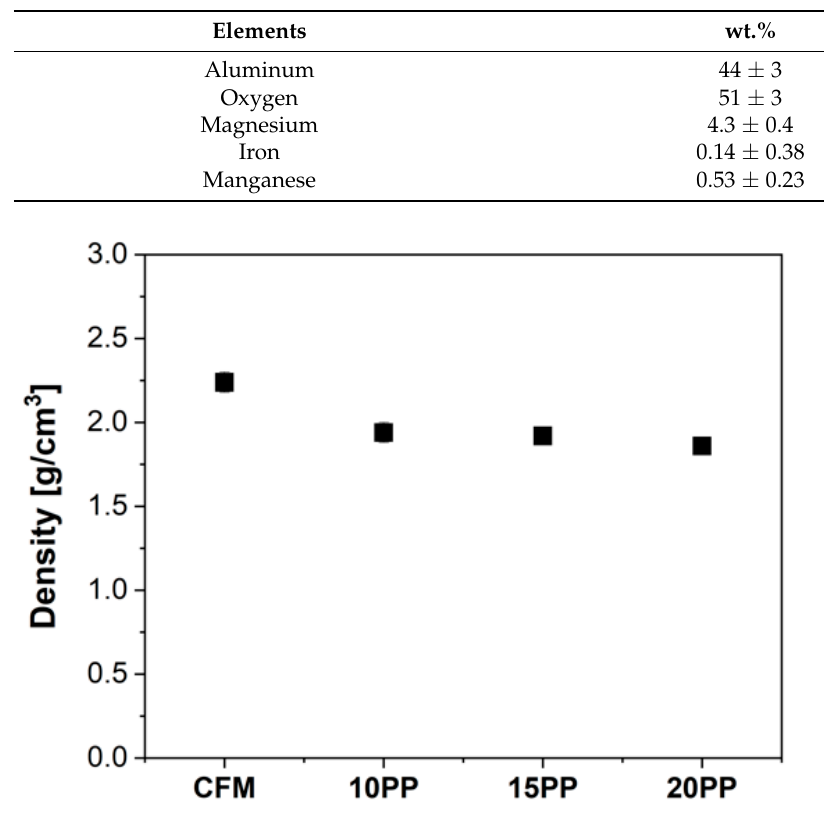
Table 4. Point EDXS analysis on PP waste particles.